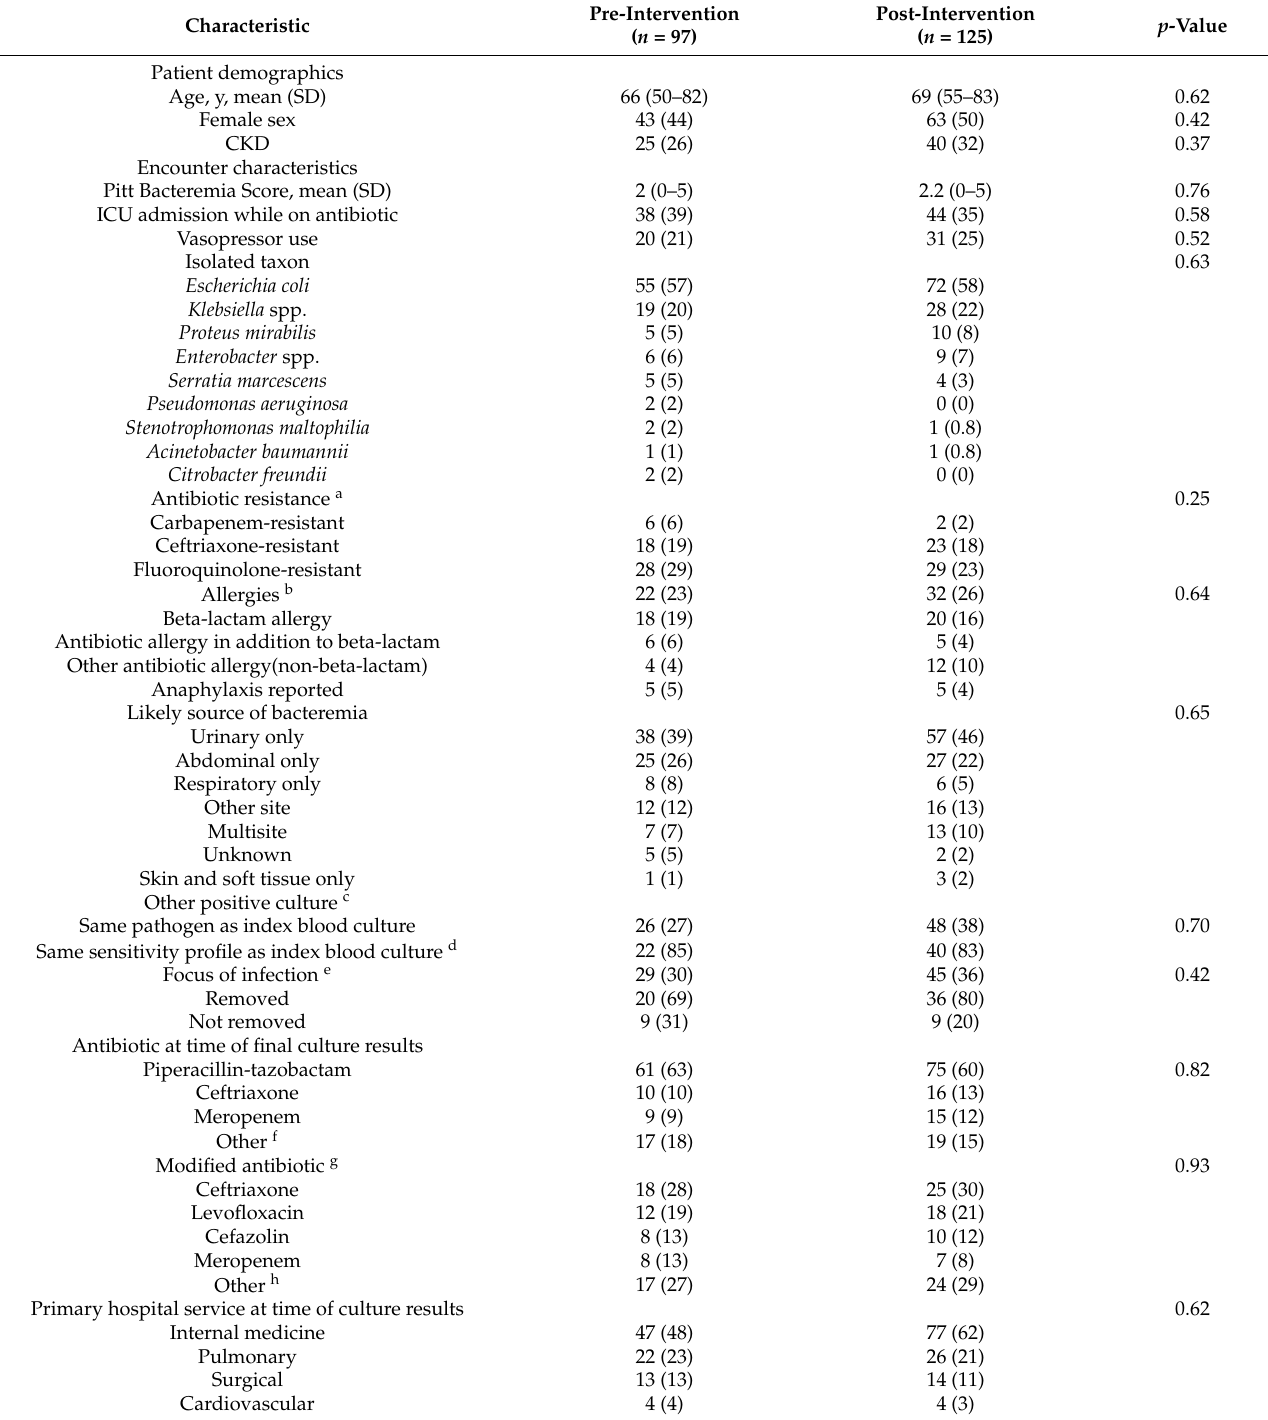
Table 1. Baseline demographics and clinical characteristics of patients included in the